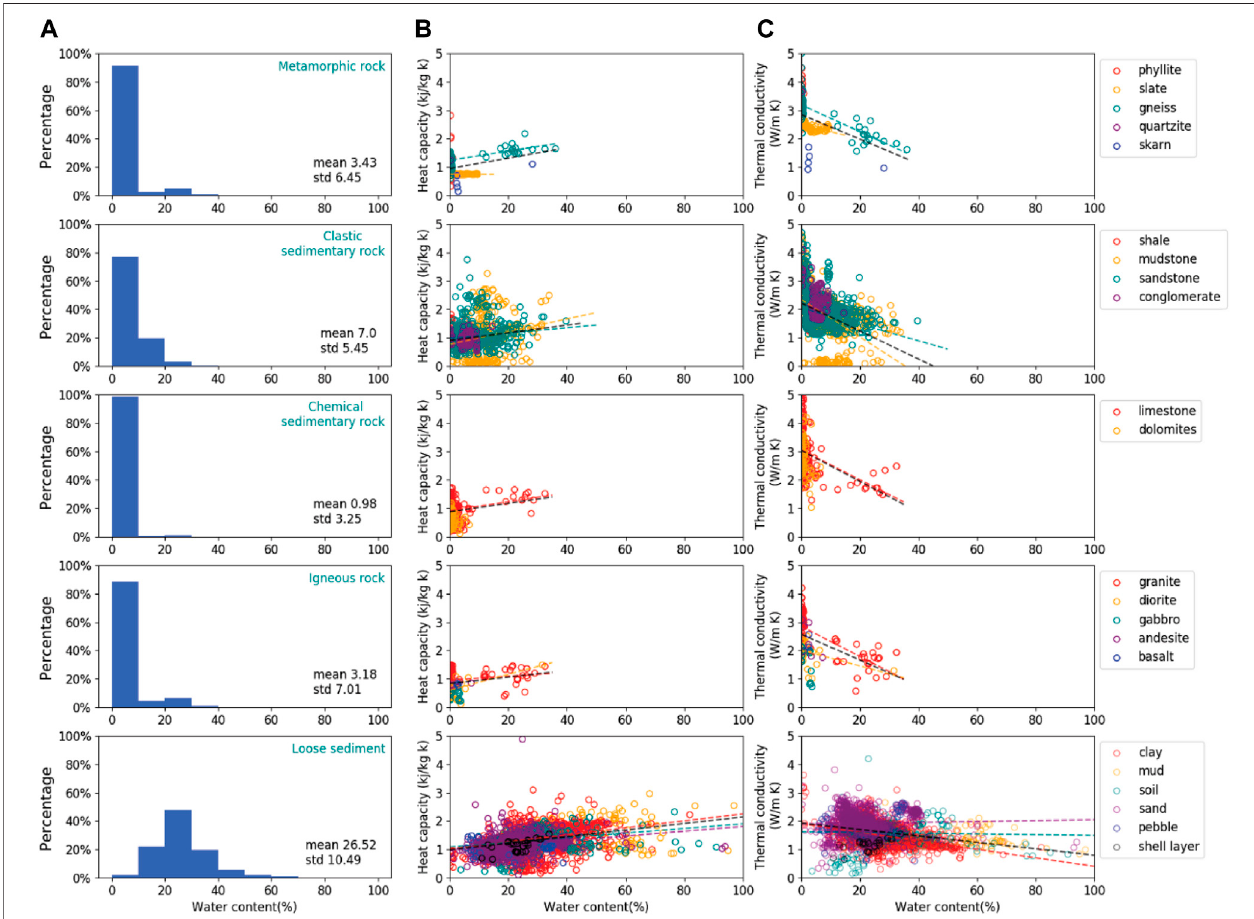
FIGURE 4 | Histograms of water content (A) and its regression analysis with respect to heat capacity (B) and thermal conductivity (C) of rock and soil samples.